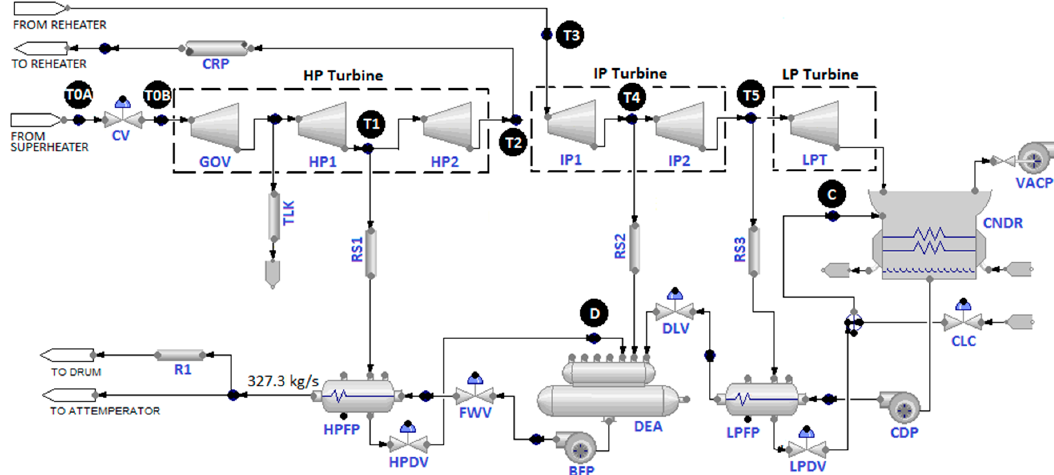
Figure 3. Balance of Plant model implemented in ProTRAX v7.2 software environment, where: CRP,